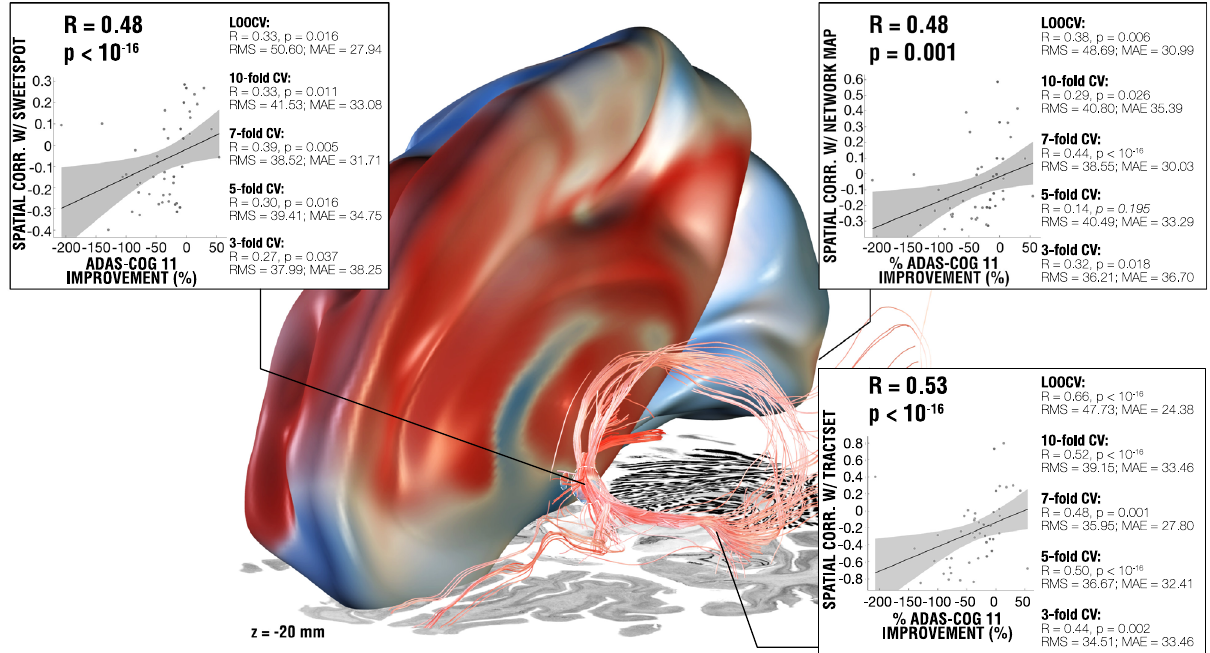
Fig. 5 | Results summary including the models from DBS fi ber fi ltering, sweetspotmappingandnetworkmapping. Thethreelevelsofanalysiswereable to explain a similar amount of variance of clinical outcomes when analyzed in a circular nature (see scatterplots; ∼ 16 – 19%) and led to signi fi cant cross-predictions ofclinicaloutcomesacrossleave-one-patient-outandmultiplek-folddesigns,plots show fi tting of a linear model that represents the degree to which stimulating